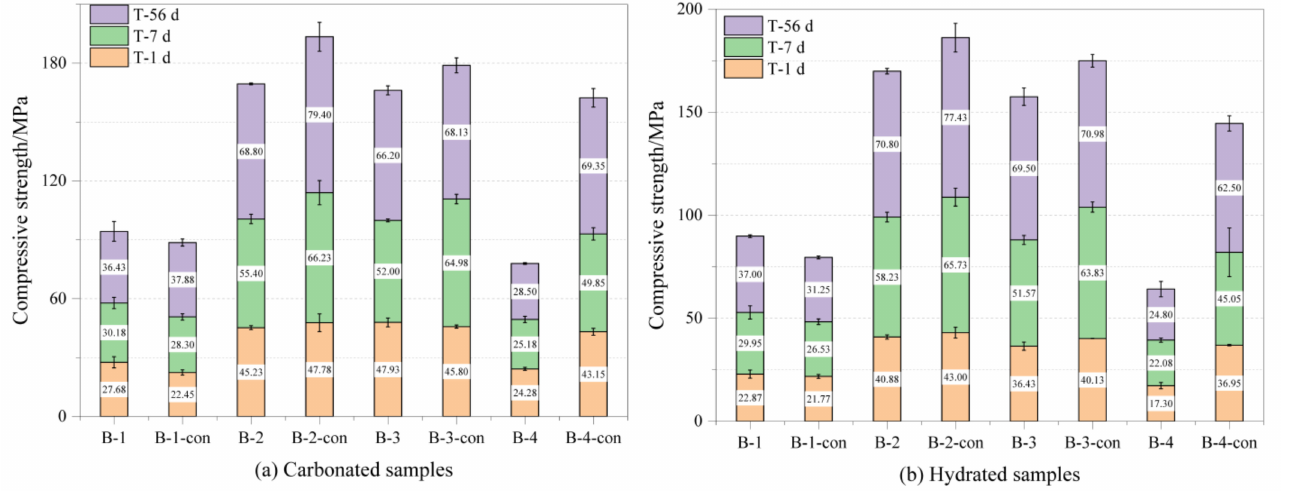
Figure 6. Compressive strength of carbonated and hydrated specimens. ( a ) Carbonated samples; ( b ) Hydrated